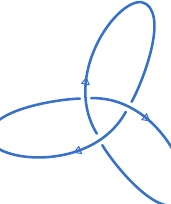
Figure 4 . A diagram for the left-handed